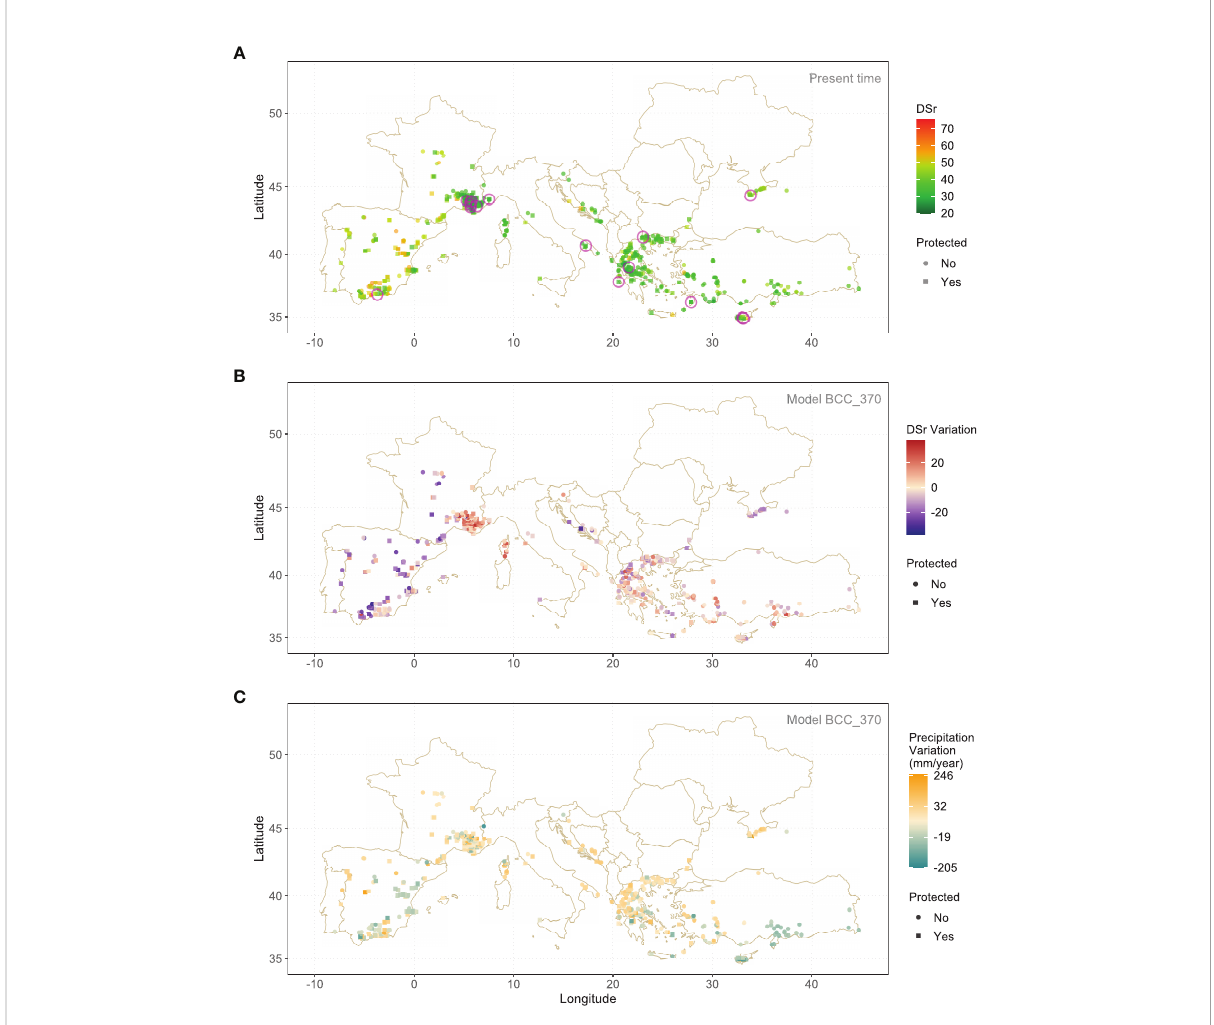
FIGURE 3 (A) DSr predicted median value, using Random Forest, for wild accessions under present climate conditions. (B) Variation of the same parameter according to BCC370 model. Encircled samples in (A) show a low DSr ( fi rst quartile) both in present time and in the future and are located inside a protected area. (C) Variation of annual